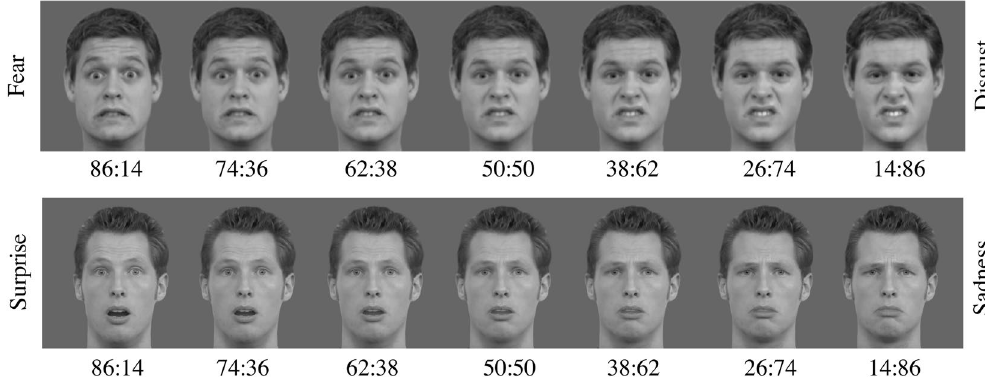
Figure 1. Examples of continua of morphed emotions used in the experimental task of Facial megamix expressions. The first continuum represents a combination of fear and disgust (identity 1) and the second continuum represents a combination of anger and sadness (identity 2).